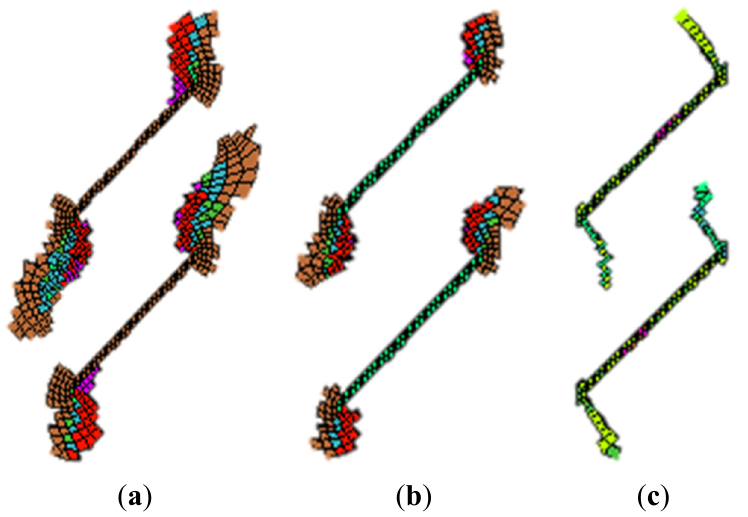
Figure 4. Numerical simulation results using elasto-plastic, strain softening and elastic